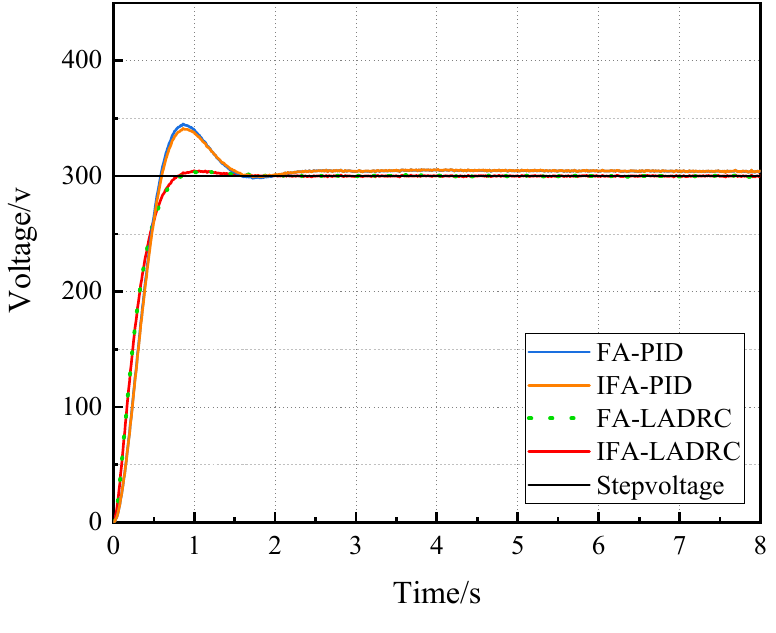
Figure 7. Step response curve.